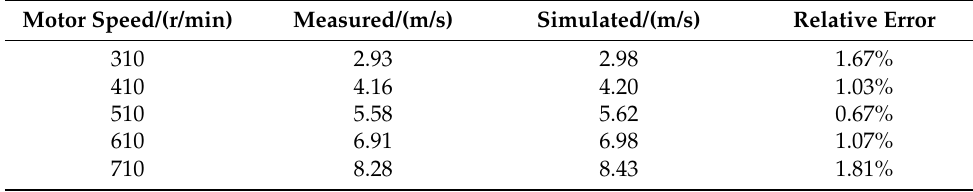
Table 1. Comparison of measured and simulated speeds.